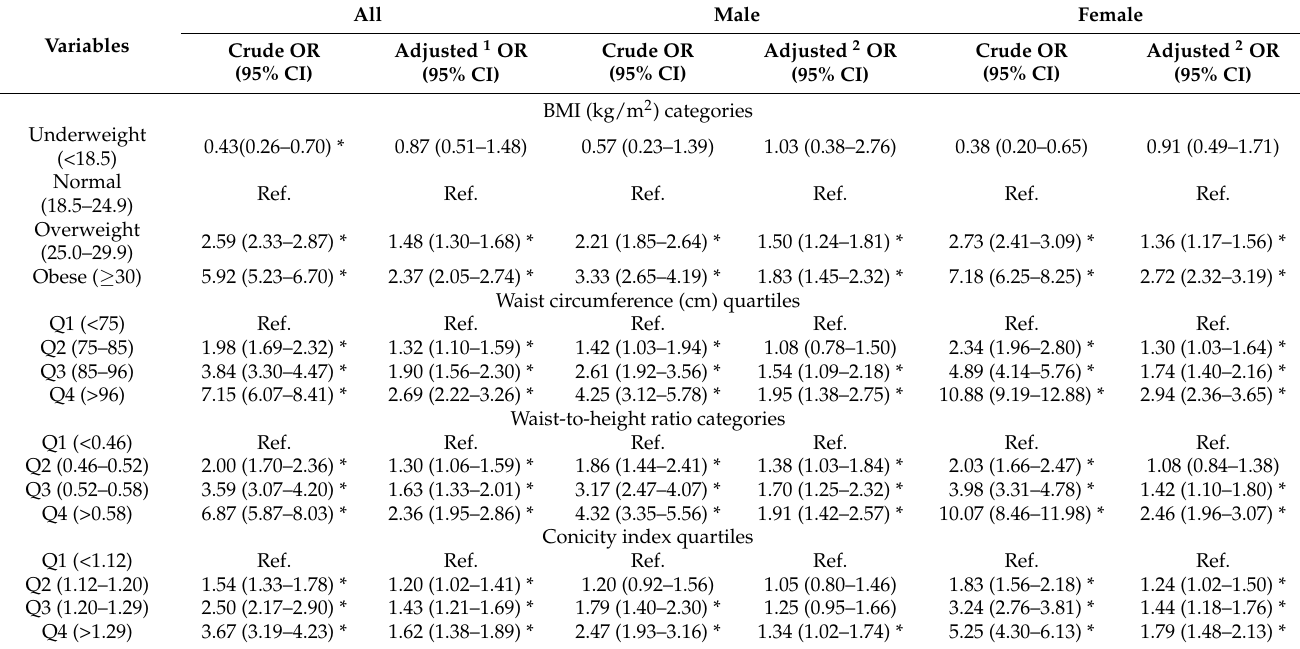
Table 3 demonstrates the predictive performance of the four anthropometric indicators based on ROC curve analysis. In females, the highest AUC was recorded for BMI (0.729; 95% CI: 0.720–0.738), followed by WHtR (0.725; 95% CI: 0.716–0.734). The difference between these two AUCs was not statistically significant ( p = 0.279). The AUC for BMI was significantly higher than that for WC ( p < 0.001) or CI ( p < 0.001). The optimal BMI and WHtR cut-offs for identifying females with HTN were 27.01 kg/m 2 (sensitivity 66.1% and specificity 68.2%) and 0.53 (sensitivity 74.0% and specificity 59.9%), respectively. No statistically significant difference was observed between the AUCs for BMI (0.648; 95% CI: